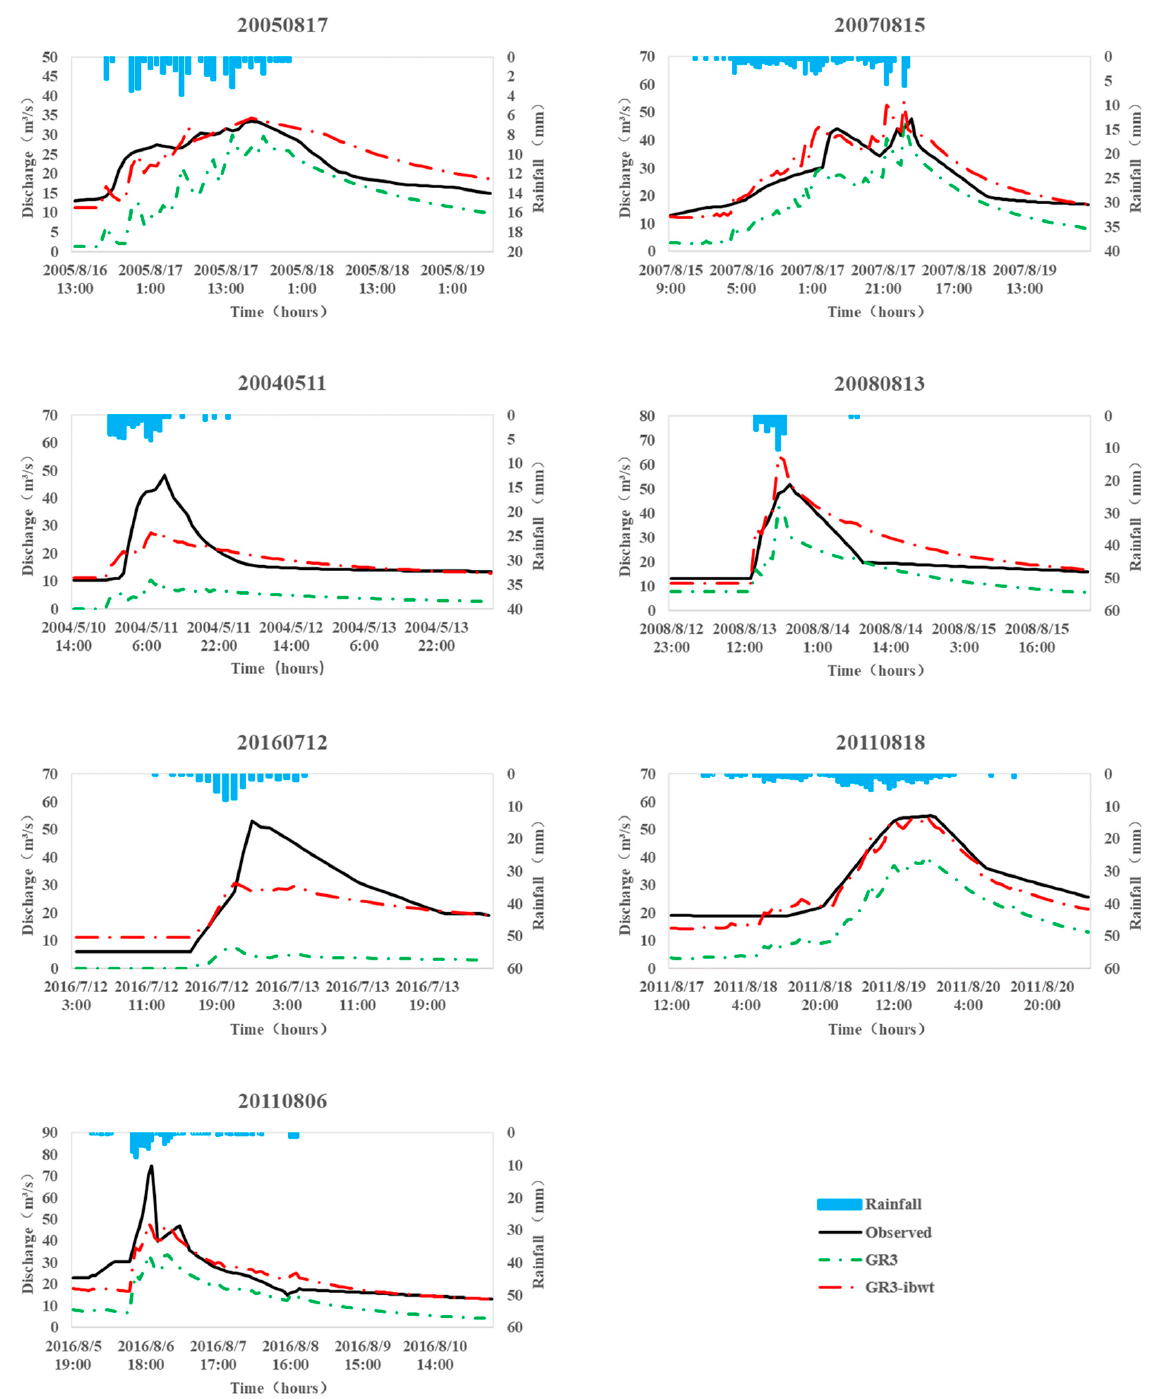
Figure 8. Time history of discharge at the outlet gauging station in small flood processes .